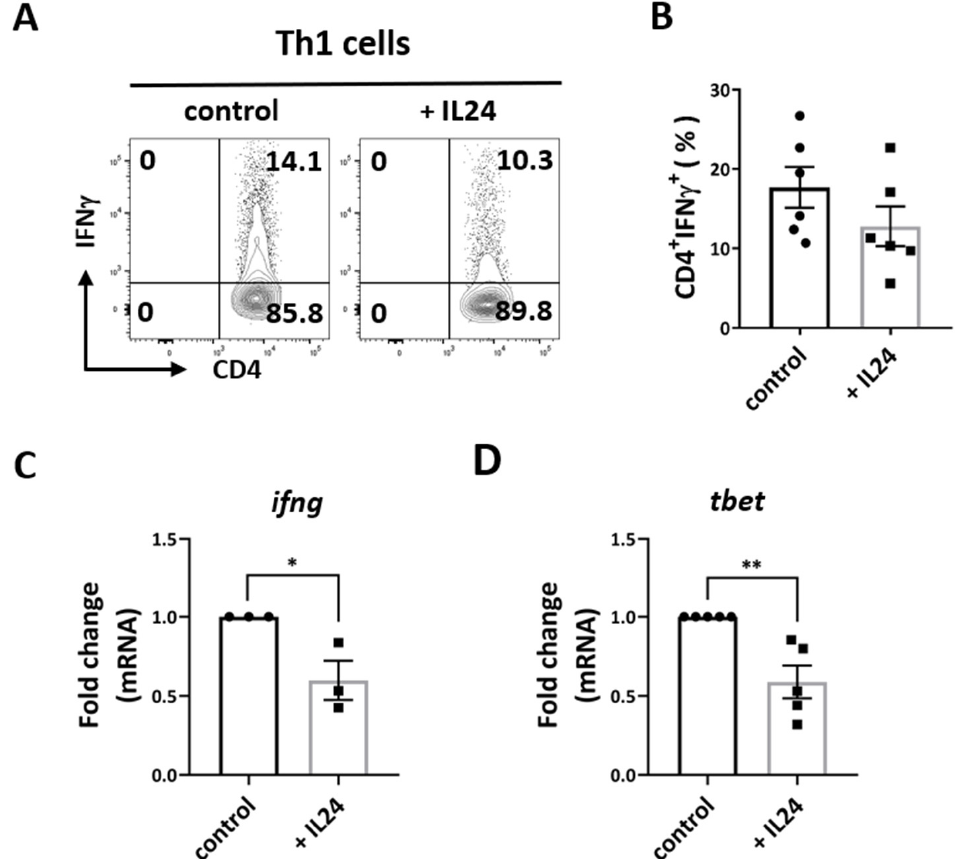
Figure 1. CD4 + CD62L + T cells from spleens and LNs of C57BL/6 mice were isolated and polarized under Th1 conditions with anti-CD3/CD28 antibodies for 3 days, with and without recombinant IL-24. ( A , B ) Representative FCM plots ( A ) and compiled data ( B ) of IFN- γ expression in Th1 cells. Data represent means ± SEMs of six independent experiments. ( C , D ) The relative gene expression of ifng and tbet in Th1 cells. Data represent the means ± SEMs of three ( C ) or five ( D ) independent experiments. * p < 0.05, ** p < 0.01, Student’s t test.